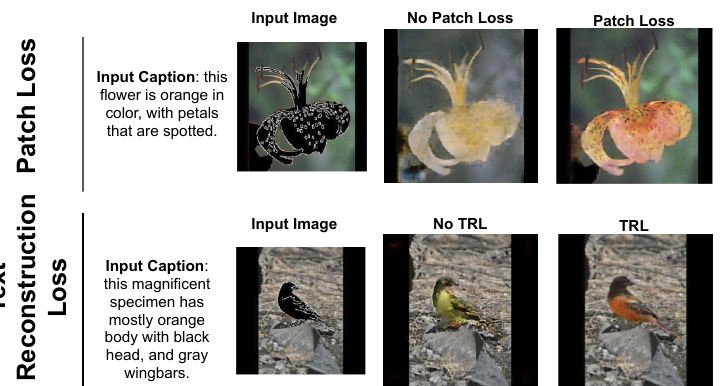
Figure 12. Region consistency and color-pattern generation are compared when using the Patch Loss and TRL,